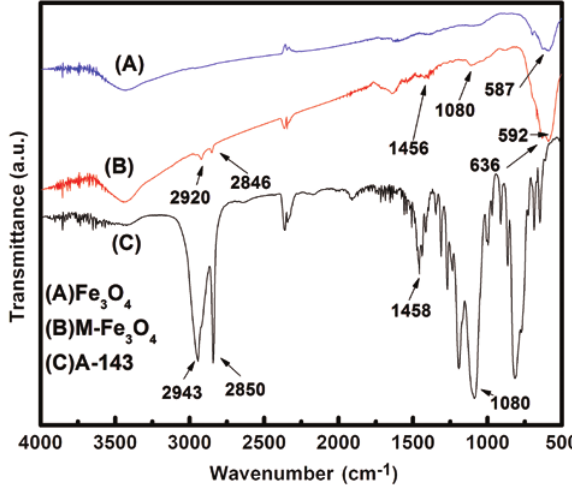
Figure 3 Fourier transform infrared spectrometer spectra of A-143, Fe O , and M-Fe 3 4